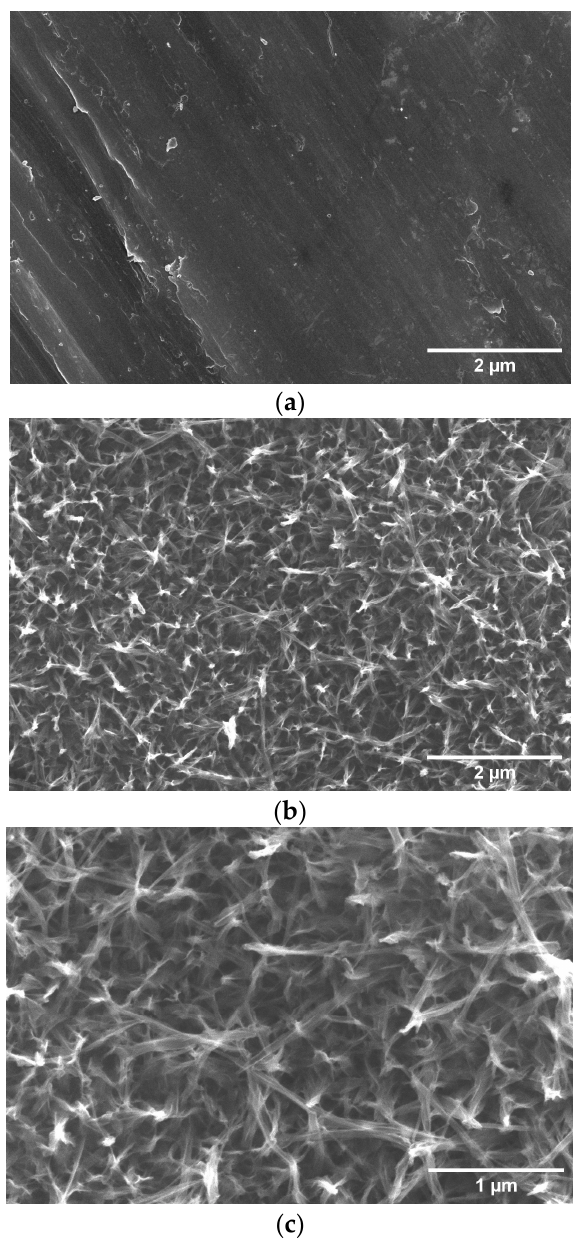
Figure 1. Top-view SEM image of Ti surface before ( a ) and after ( b ) alkaline hydrothermal treatment, and alkaline hydrothermal treatment at higher magni fi cation ( c